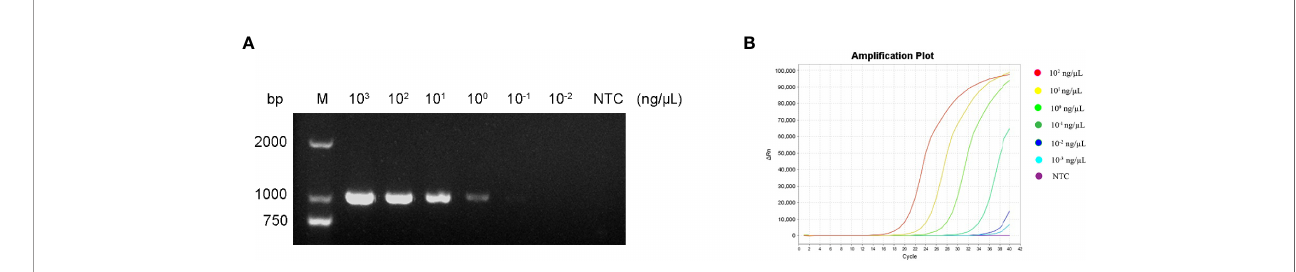
FIGURE 10 | (A) Sensitivity of the PCR assay. (B) Sensitivity of the qPCR assay. The NTC strip is the control reaction without